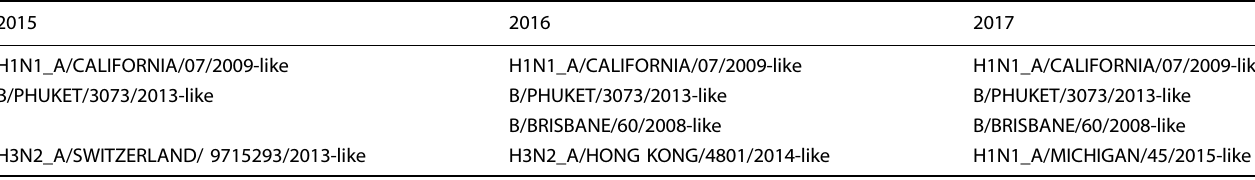
Table 1. WHO-recommended southern-hemisphere in fl uenza vaccine formulations for trivalent and quadrivalent vaccines for each vaccine year.